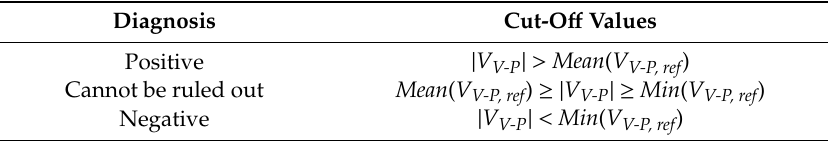
Table 1. Definition of the quantitative diagnostic scale.